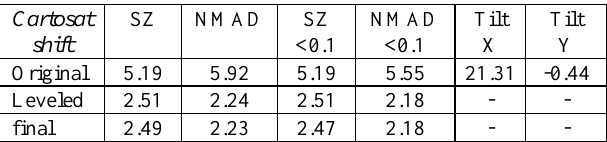
Table 13: Accuracy figures and DSM-tilt over full range [m], Cartosat-1 against reference DSM; <0.1 = for slope below 0.1; orientation by bias correction with shift